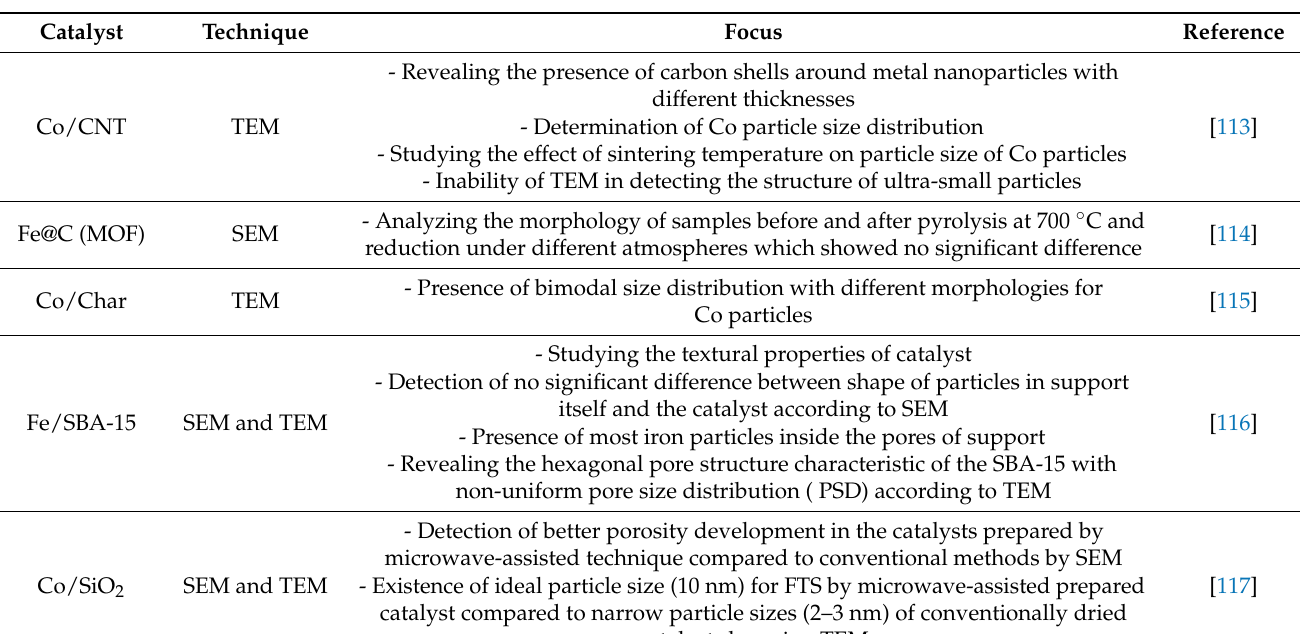
Table 7. Microscopy-based techniques for analysis of physicochemical properties of Fe- and Co-based FT catalysts. Catalyst